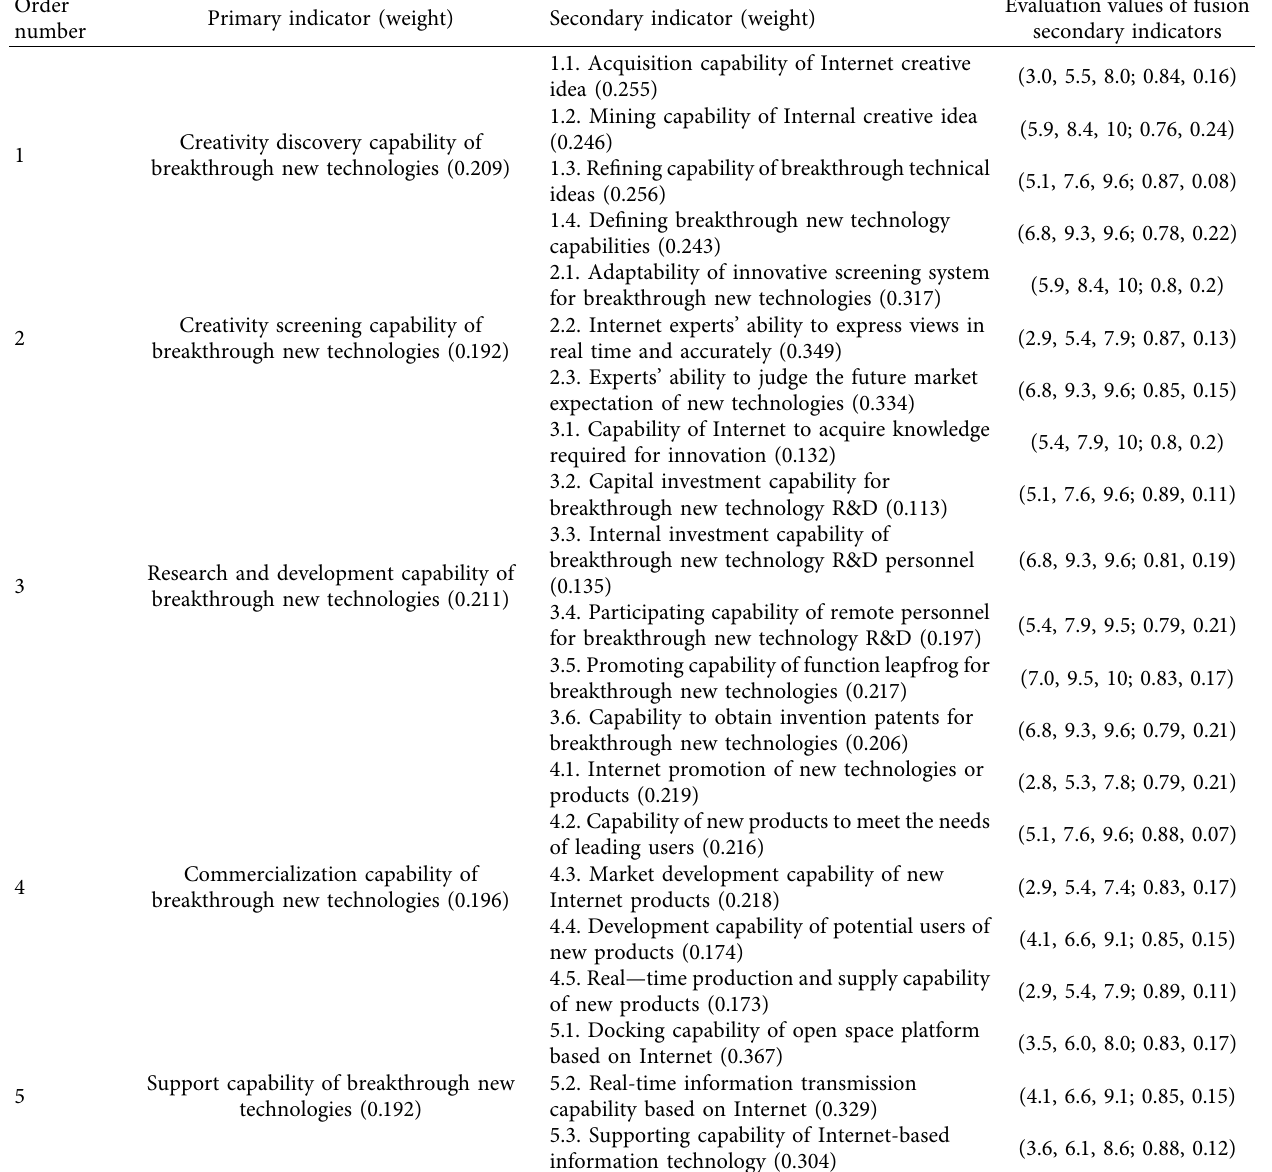
Table 4: Experts’ values and indicators’ weights of fusion secondary indicators.